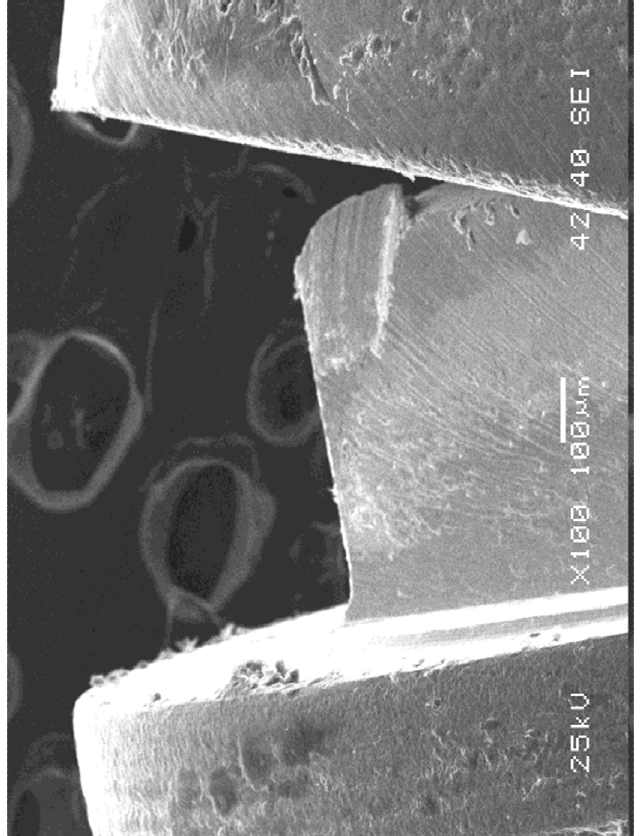
Figure 6. On the side opposite the angulation of the abutment, the gap opened considerably, and the hexagon suffered crushing or scratching, at times with the loss of substance. hexagon suffered crushing or scratching, at times with the loss of